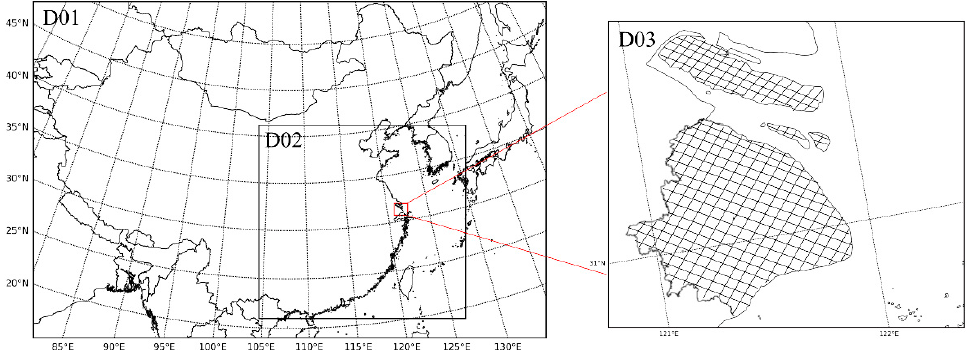
Figure 1. The modeling domains of WRF-CMAQ (Weather Research and Forecasting-Community Multiscale Air Quality). The outermost domain covers all of East Asia, the intermediate domain covers the eastern part of China, and the innermost domain covers the whole of Shanghai. (The urban areas of Shanghai are marked with grid).